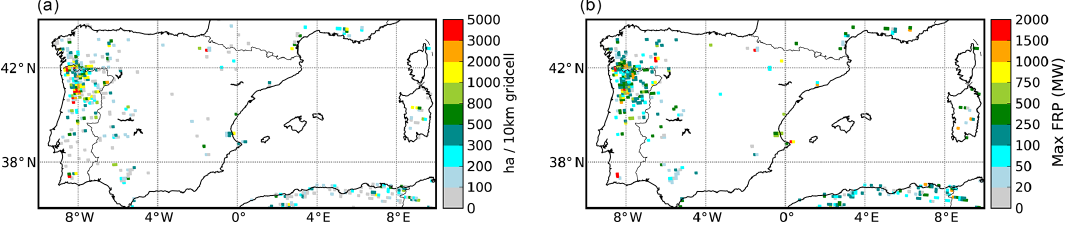
Figure 4. Total burned area derived from the MODIS MCD64A1 product and mapped on a 10km resolution grid (a) and maximum FRP from the MODIS MOD14 product on the same grid (b) for observations from June to September